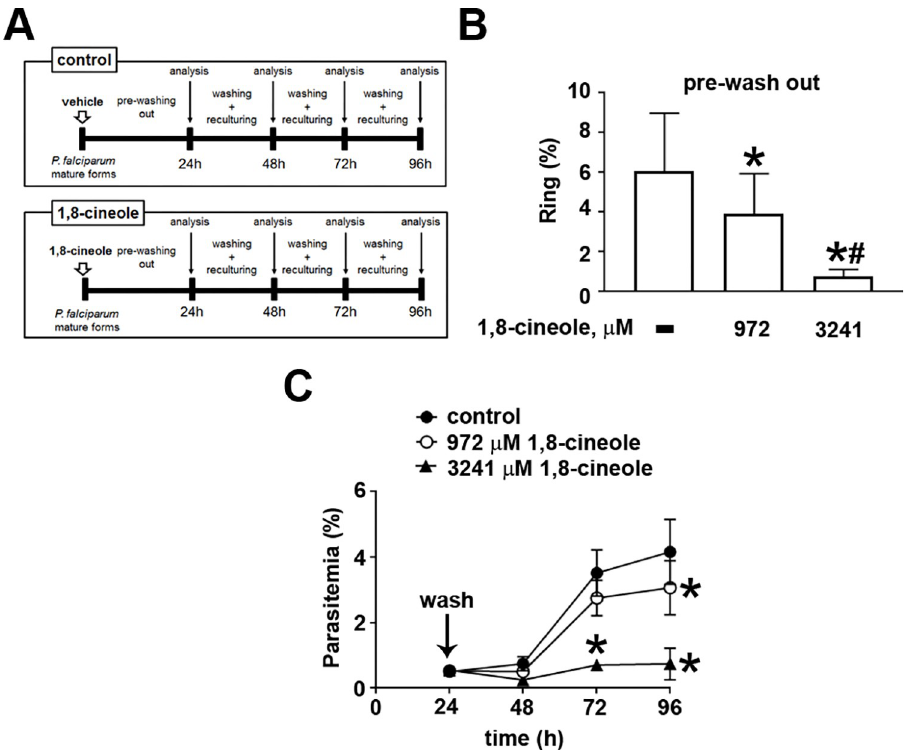
Fig 5. The inhibitory effect of 1,8-cineole on the erythrocytic cycle of Plasmodium falciparum is not reversible. (A) Experimental design. Synchronized cultures of erythrocytes infected with P . falciparum schizonts were incubated or not with 972 or 3241 μ M 1,8-cineole (white arrows) for 24 h. Cells were harvested, and parasitemia was determined by optical microscopy (analysis). The cells were then washed, and parasitemia was adjusted to 0.5% before reculturing them in absence of the compound for an additional 3 consecutive days. Parasitemia was determined every 24 h (analysis at 24, 48, 72, and 96 h after the first washing). (B) The inhibitory effect of 1,8-cineole on parasitemia levels in the first 24 h, before washing out the compound ( n = 3). (C) The effect of the time course of 1,8-cineole on parasitemia after washing out the compound from the cells ( n = 3). The results are presented as the mean ± SD. � P < 0.05 versus control, # P < 0.05 versus 972 μ M